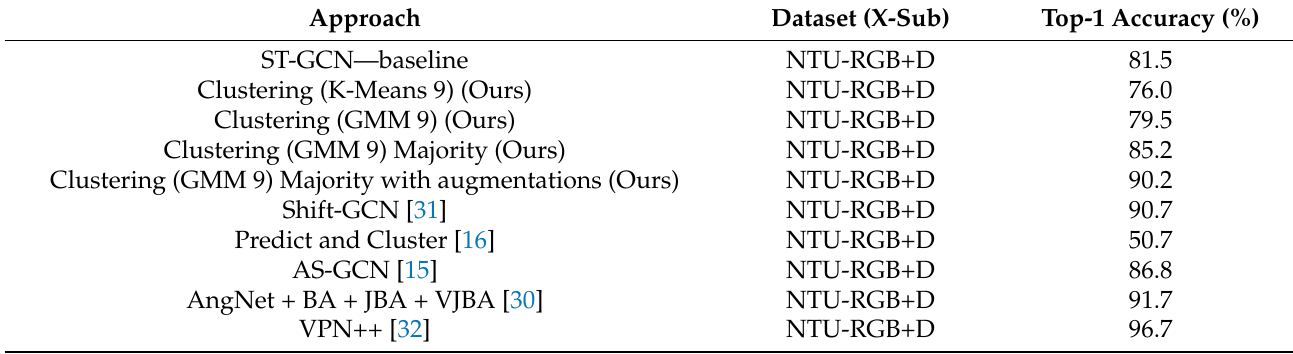
Table 12. Comparison of the proposed approach with state of the art methods (NTU-RGB+D dataset).